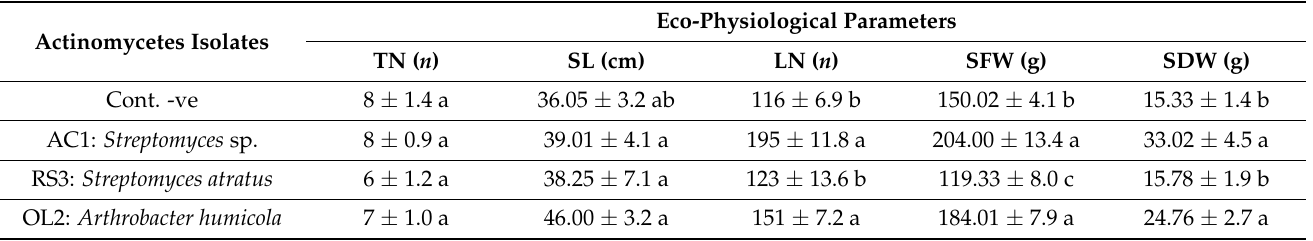
Table 3. Effect of Actinomycetes isolates on eco-physiological parameters of tomatoes (health control).